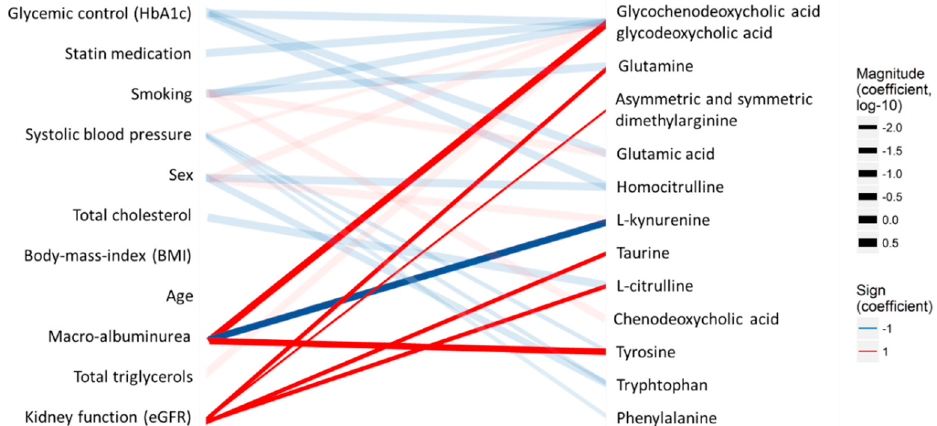
Figure 2. Associations between clinical measurements (left) and the quantified analytes (right) in the type 1 diabetes T1D cohort. The lines indicate statistical associations (red—positive association and blue—inverse / opposite association; line width—strength of the association). Associations directly related to diabetic kidney disease are highlighted with bold lines.